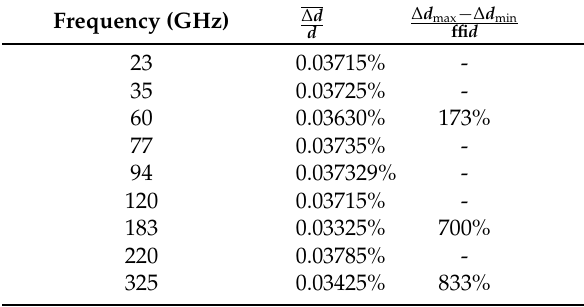
Table 1. Distance accuracy ∆ d { d and resolution degradation p ∆ d max ´ ∆ d min q{ δ d when the target is at a distance of d “ 1 km